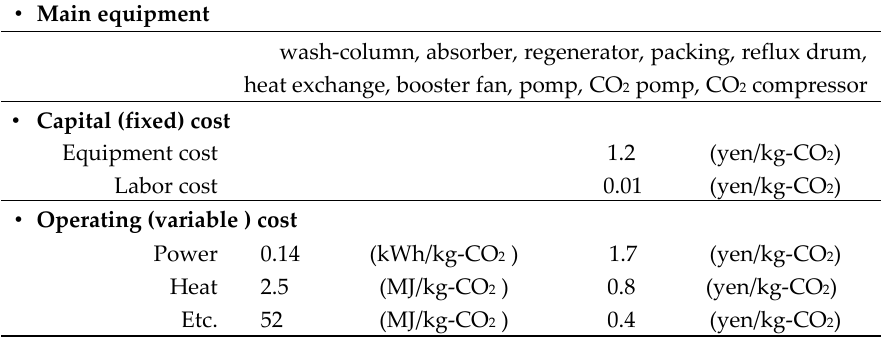
Table 3. Cost and energy consumption of the main devices in the chemical absorption